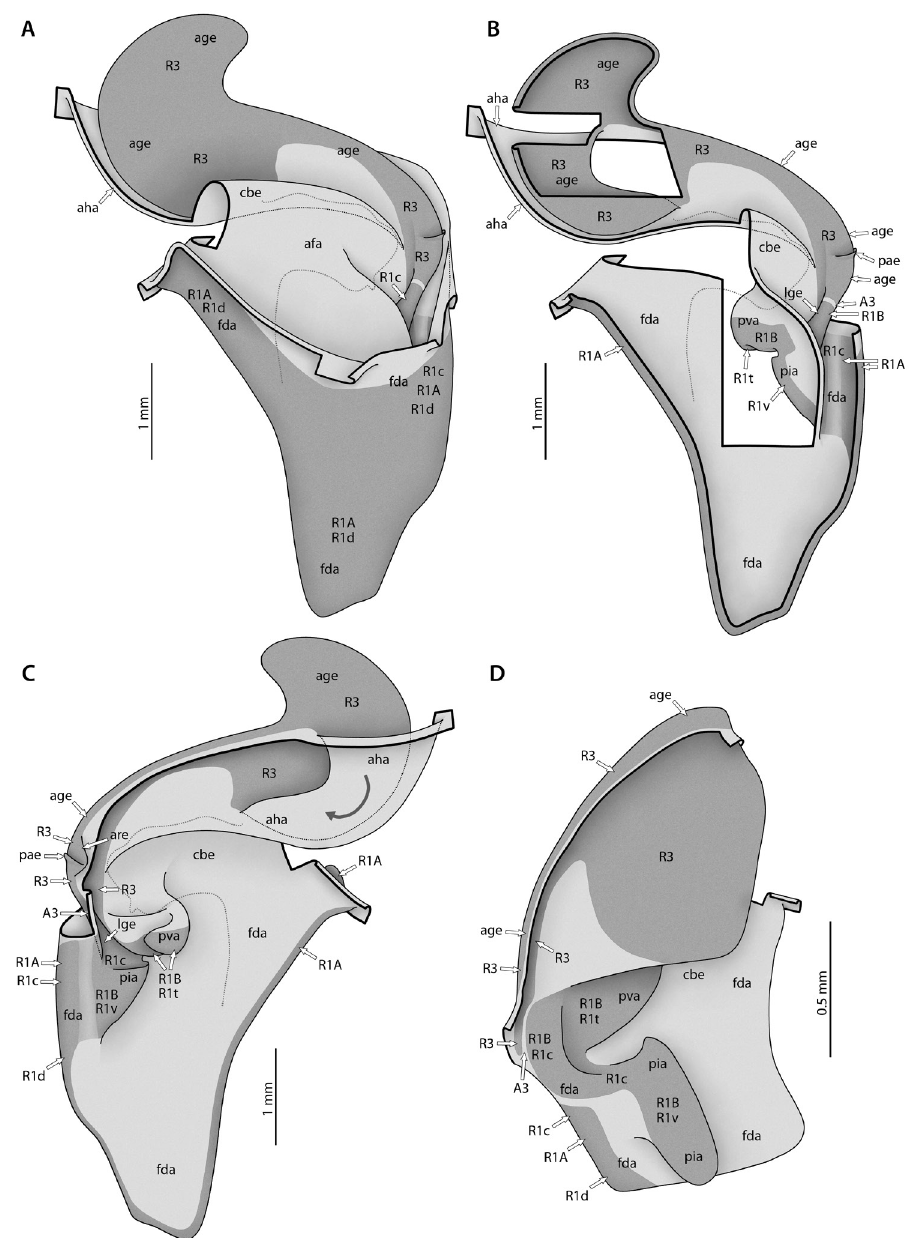
Figure 11. Annotated illustrations of the right phallomere in male genitalia for morphological use. A – C Male postabdomen, right phallomere of Sphodromantis sp. A dorsal view of intact right phallomere B dorsal view of right phallomere with many parts removed C ventral view of intact right